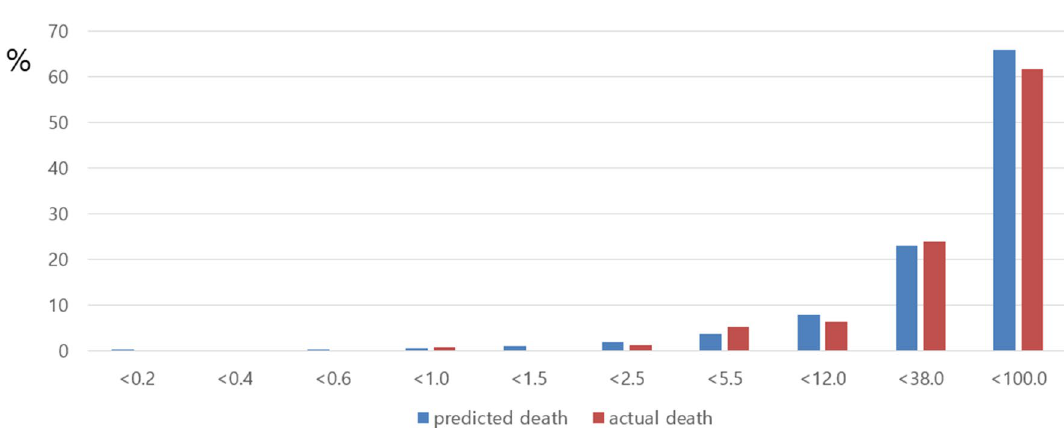
Figure 2. Probability of Predicted and Actual Deaths in development set.